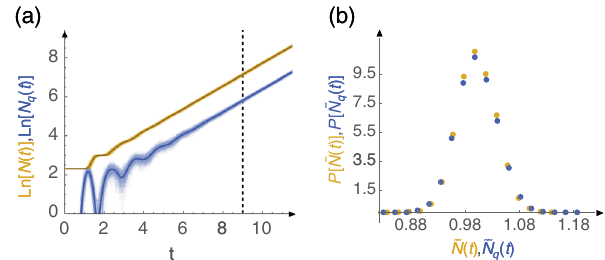
¼ 0 . 4 . T q FIG. 6. Scaling of number fluctuations during stochastic population growth. In (a), we show analytical results for the time evolution of population sizes of normal (yellow) and quiescent (blue) cells. In the steady state, they have the same exponential growth rate. Oscillations in the numbers of normal and quiescent cells are observed during the transient phase. The bold curves show the mean behavior of population numbers, calculated using our exact analytical solution. Also shown are representative stochastic trajectories that account for fluctuations in population numbers. The stochastic trajectories were computed using exact numerical simulations (see the accompanying text). In (b), we show that the mean-rescaled population number distributions of normal and quiescent cells [from t ¼ 9 in panel ˜ N ð t Þ ¼ N ð t Þ = h N ð t Þi (a)] undergo a scaling collapse. Here, and ˜ N ð t Þ ¼ N ð t Þ = h N ð t Þi . The parameter values used for these q q q ¼ 1 ; N ð 0 Þ ¼ 10 ; and N ð 0 Þ ¼ 0 . P ð τ Þ is a simulations are ν ¼ ν q q ð T Þ gamma distribution with mean ¼ 1 and COV ¼ 0 . 13 , and P q q is a gamma distribution with mean ¼ 0 . 4 and COV ¼ 0 . 1 . All timescales are measured in units of μ τ